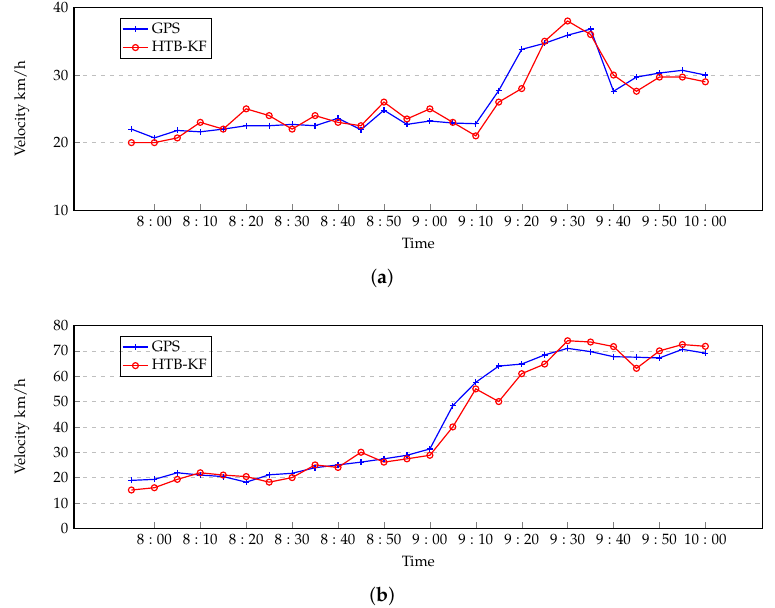
Figure 11. Velocity information reconstruction by different algorithms. ( a ) The variation of HTB-KF compare with Beijing truth GPS trajectory data velocity at 9:00–11:00. ( b ) The variation of HTB-KF compare with Shanghai truth GPS trajectory data velocity at